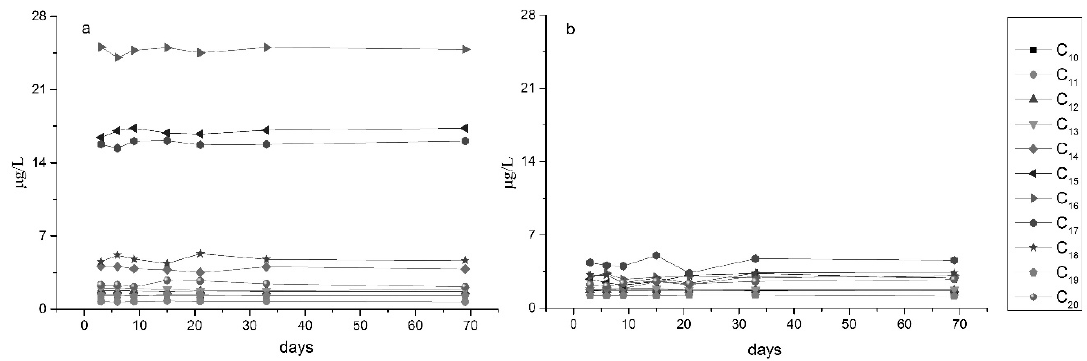
Figure 9. Content of C 10 –C 20 in liquid for ( a ) oil shale heated to 300 °C, and ( b ) oil shale heated to 500 °C.